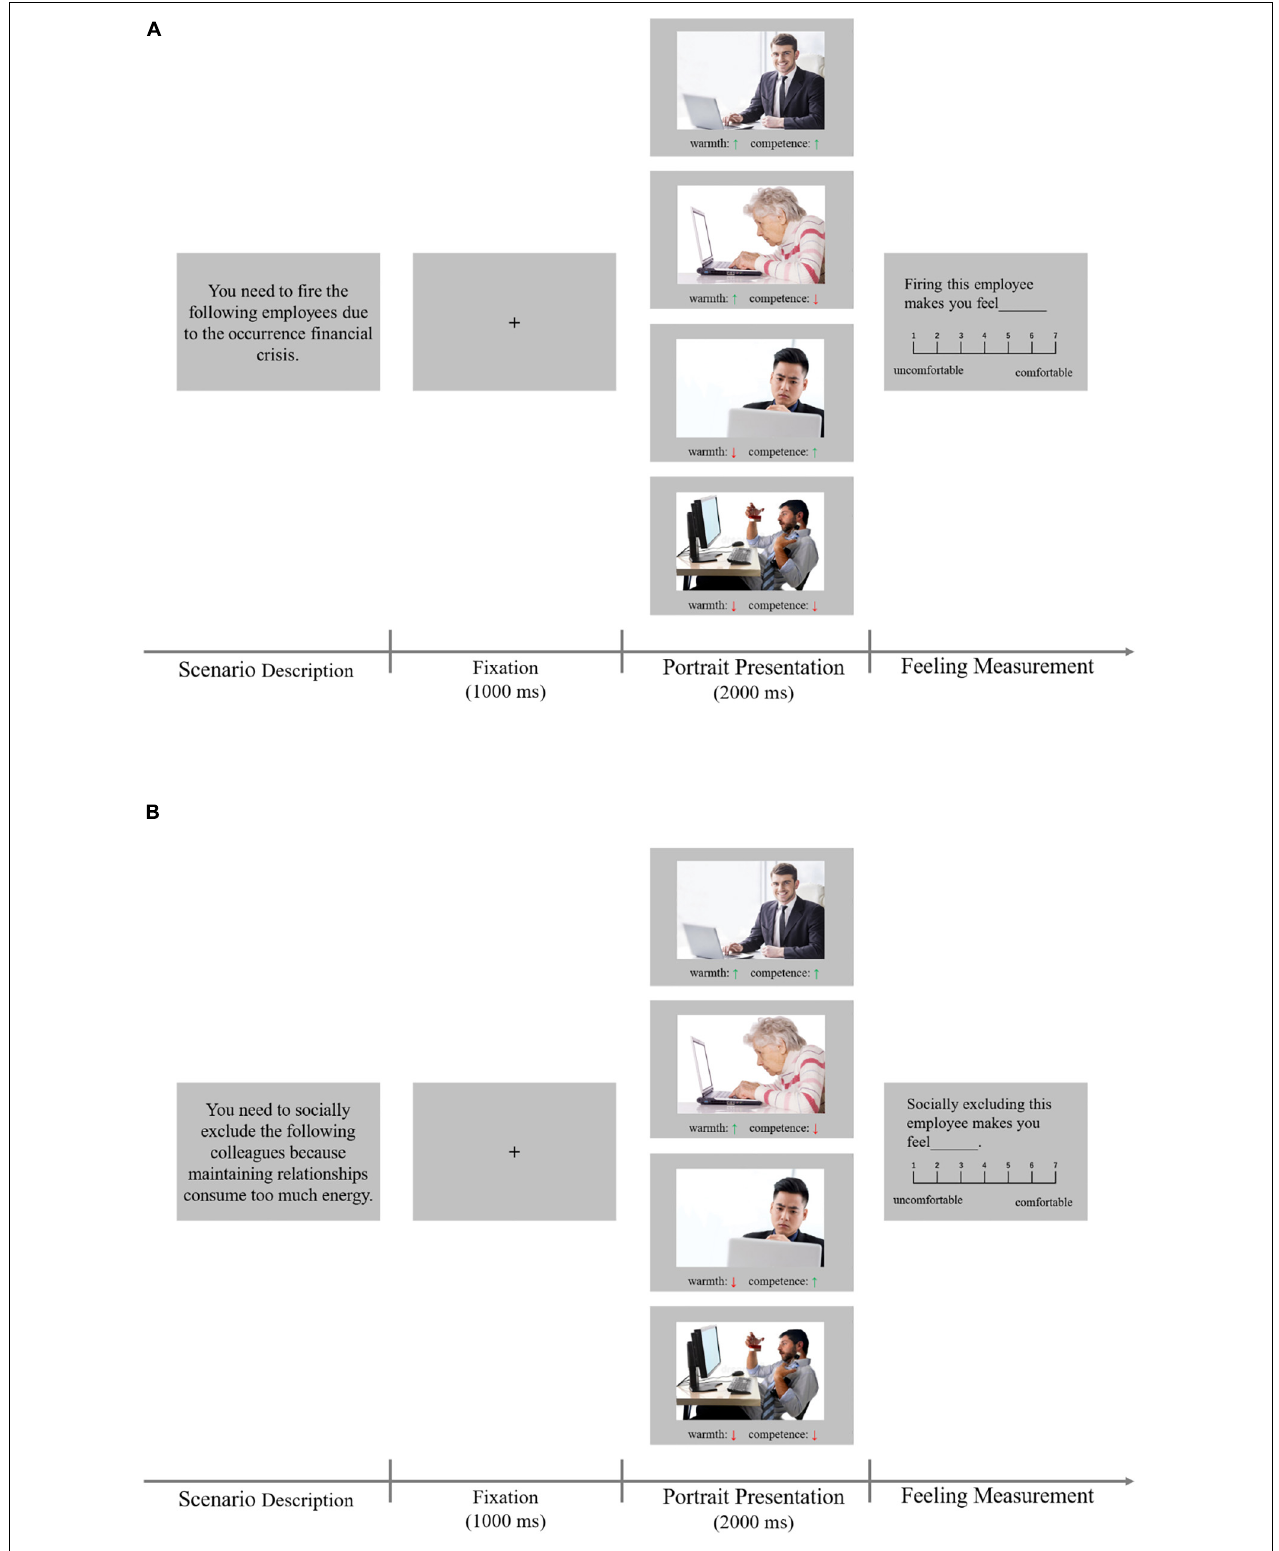
FIGURE 2 | Timeline of the experimental design. (A) Economic context. (B) Social network context.